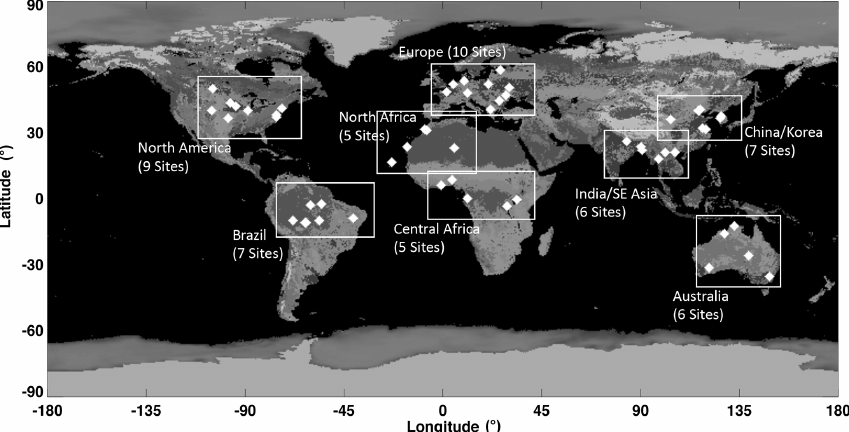
Figure 7. The location of AERONET sites and how they are grouped for calculations of the mean, bias, and RMS with respect to the MATCH and MERRA-2 optical depths found in Tables 3 and